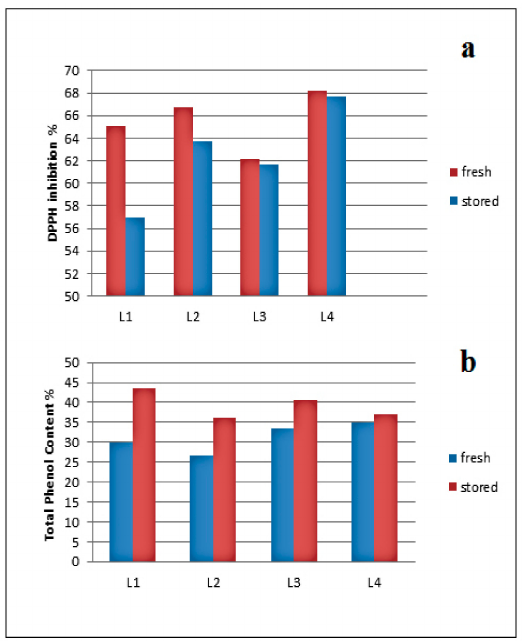
Figure 13. ( a ) Storage effect on DPPH inhibition of kraft lignin purification fractions (fresh samples in red and stored in blue); ( b ) TPC where fresh samples are in blue and stored in